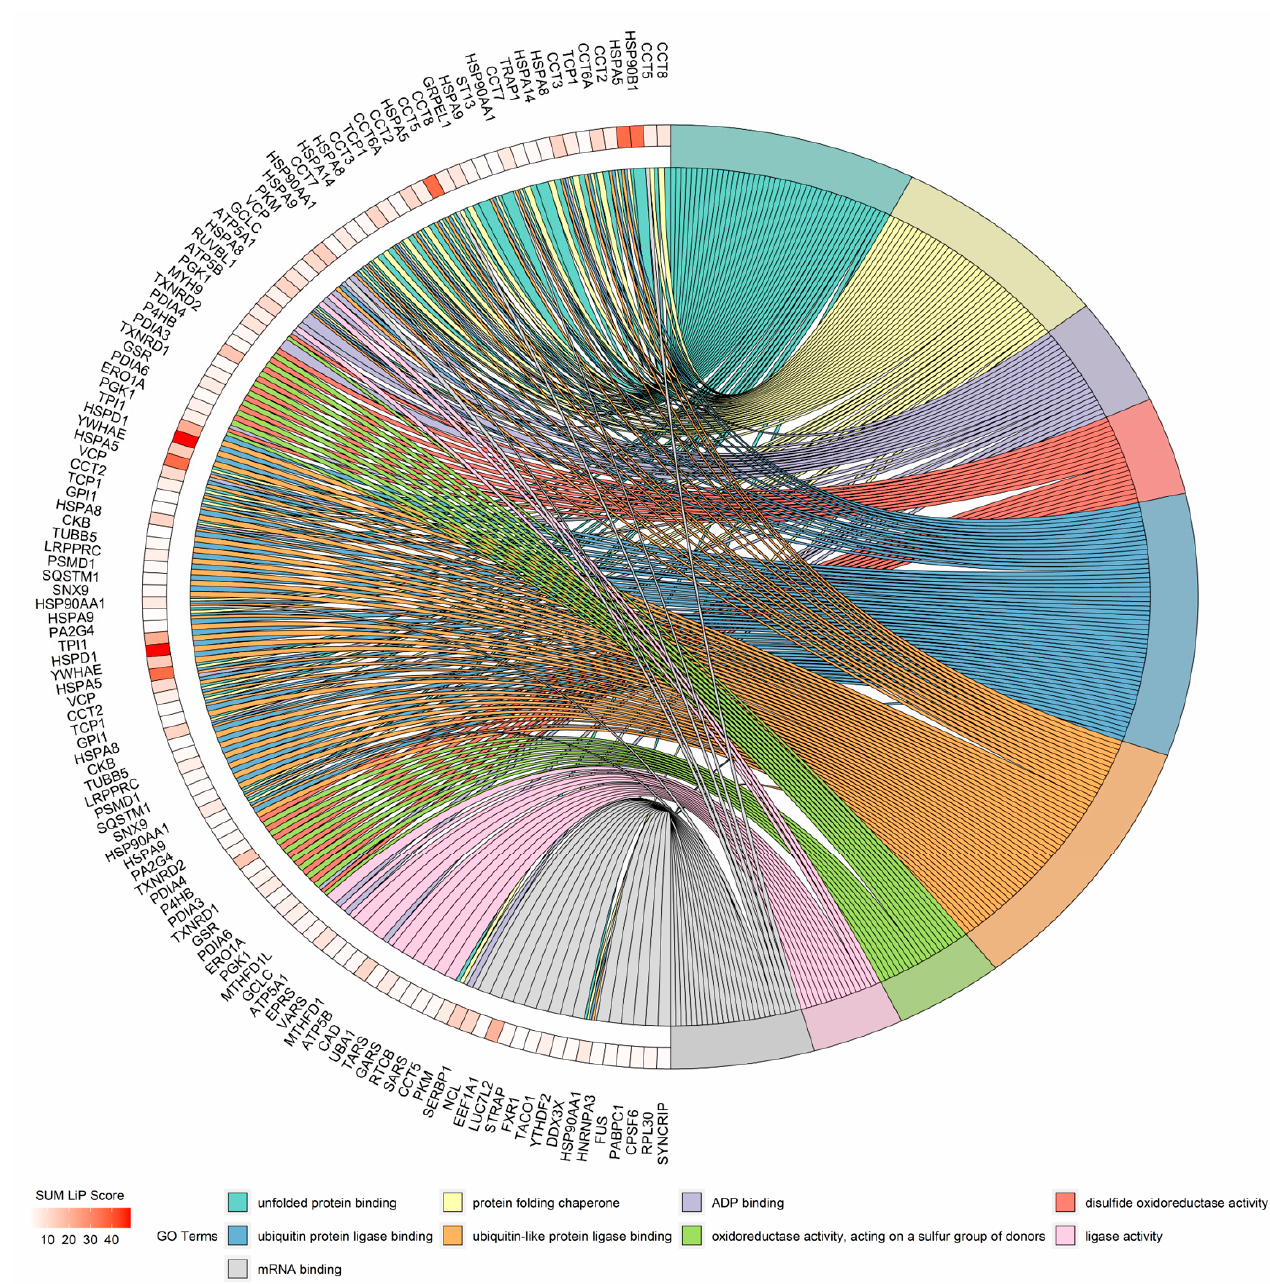
Figure 4. Gene ontology enrichment analysis of structural reads from significantly changed proteins during 24-h macrophage activation. The chord plot presents the linkages of genes and GO biological process terms.